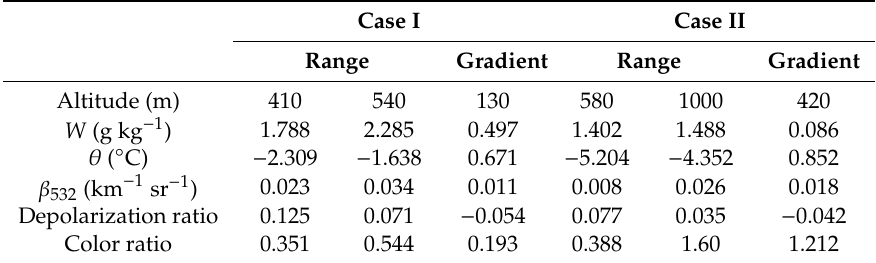
Figure 4. Vertical profiles of β 532 ( a , g ), θ ( b , h ), RH ( c , i ), W ( d , j ), depolarization ratio ( e , k ), and color ratio (532–1064 nm) ( f , l ). The shaded areas represent the layers under analysis: 410–540 m for Case I (top panels) and 580–1000 m for Case II (bottom panels). Table 3. Range of values and gradient values of the W , the θ , the RH, the β 532 , the depolarization ratio, the color ratio for Case I and Case